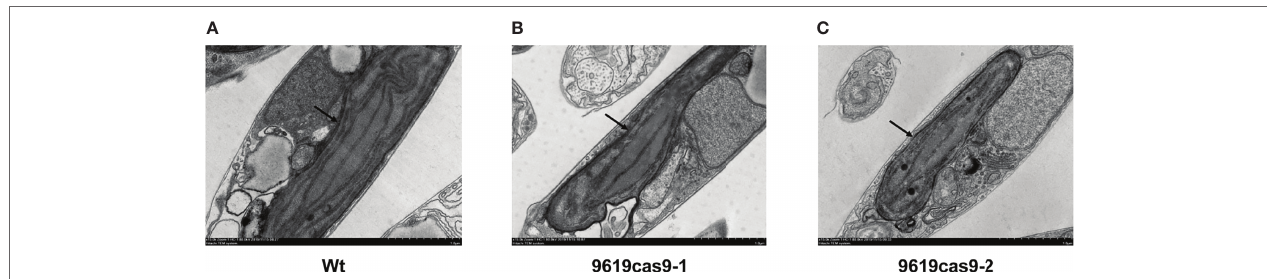
FIGURE 5 | Ultrastructure of thylakoid membranes in plastids from Wt (A) and the ptMGD2 mutants (B, C) . The arrows indicate the underdeveloped structures of mutants. Bar = 1.0